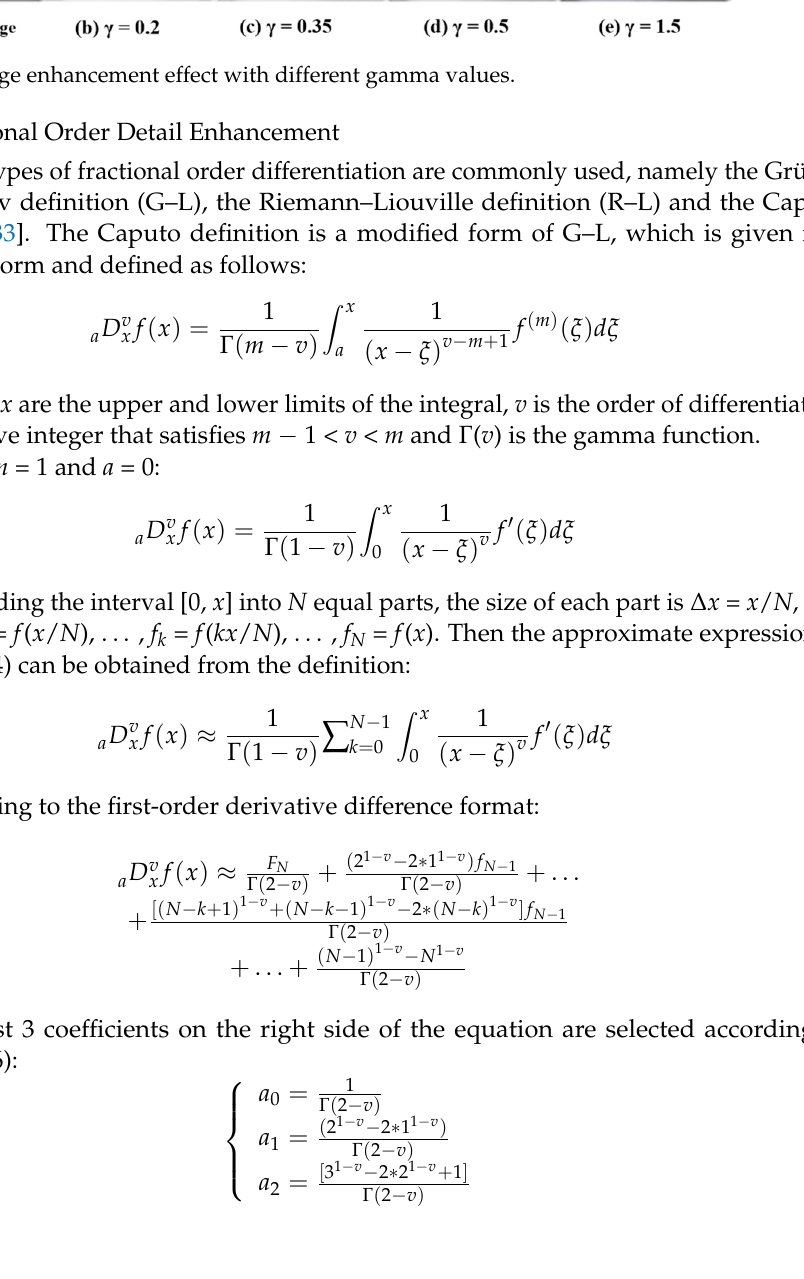
Figure 3. Image enhancement effect with different gamma values.